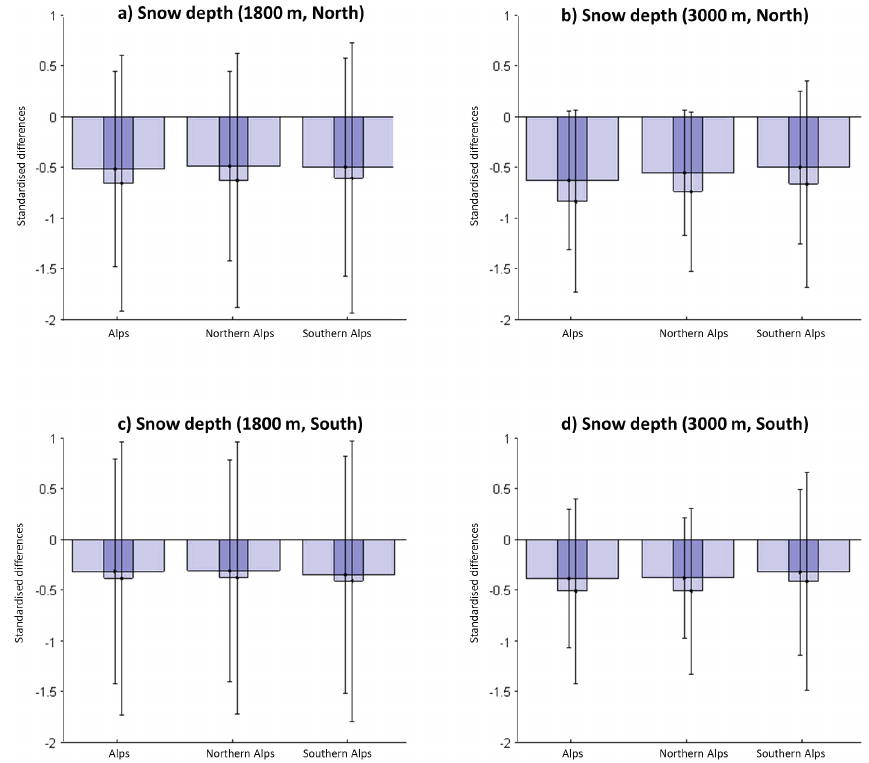
Figure 6. Same as for Fig. 4 but with regard to snow depth (north and south facing slope, at 1800 and 3000ma.s.l.).